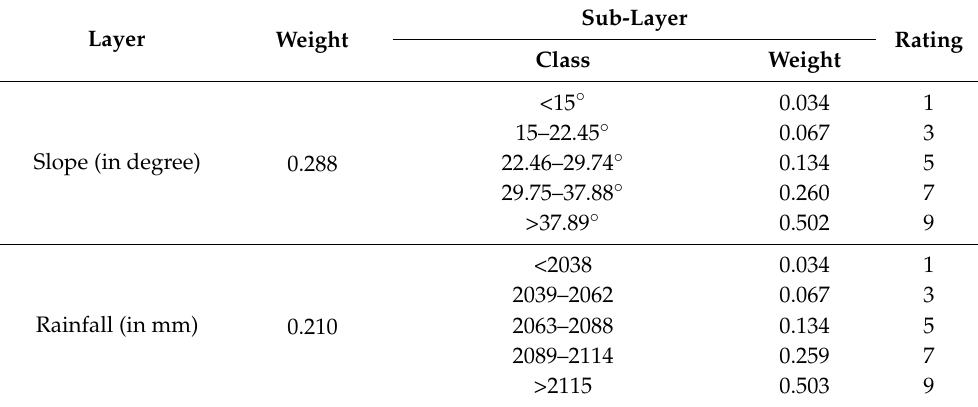
Table 5. LSM weights and rating system of different landslide conditioning